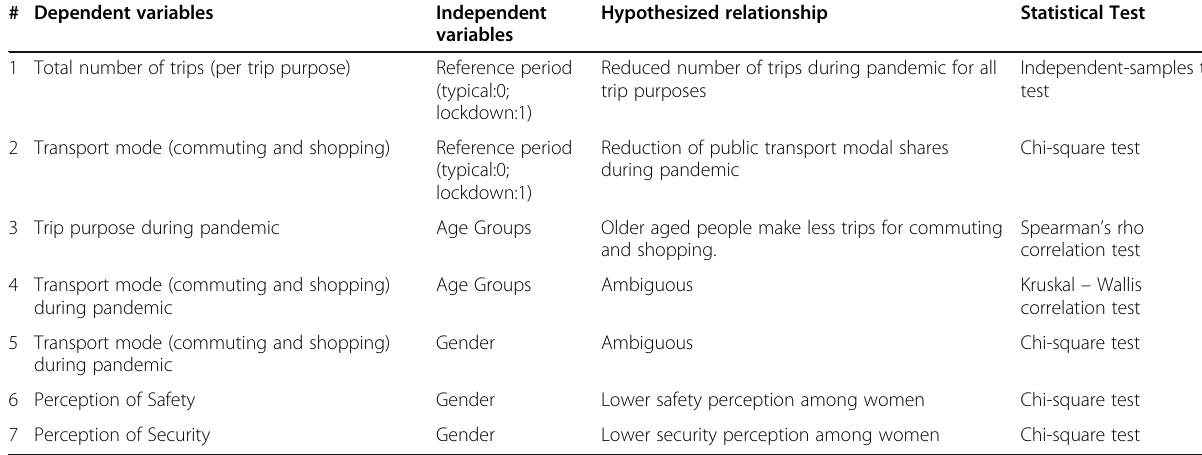
Table 3 Initial hypotheses and test statistics used for investigating the relationships between mobility variables and socioeconomic